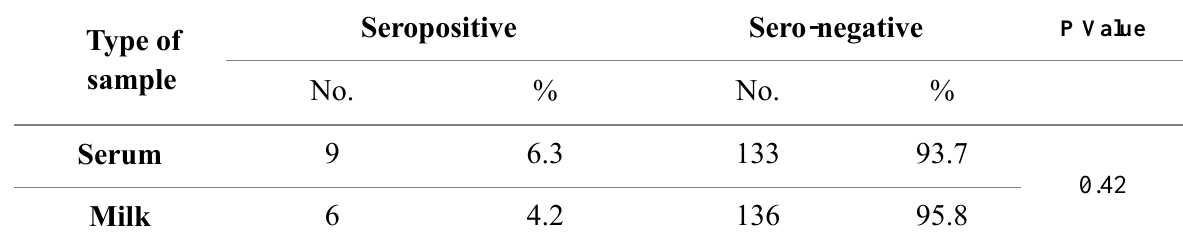
Table 1. The seropositivity of anti F. hepatica IgG antibodies in Sera and Milk of goats by ELISA (No =142).